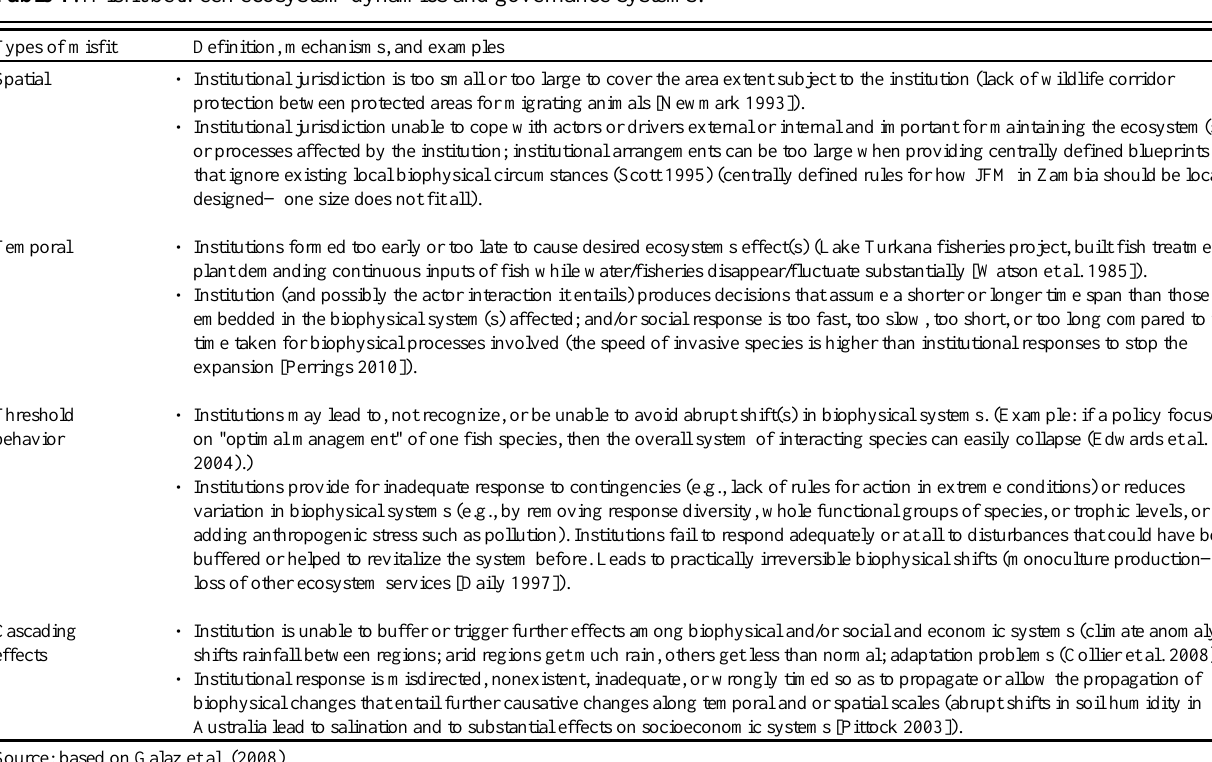
Table 1 . Misfit between ecosystem dynamics and governance